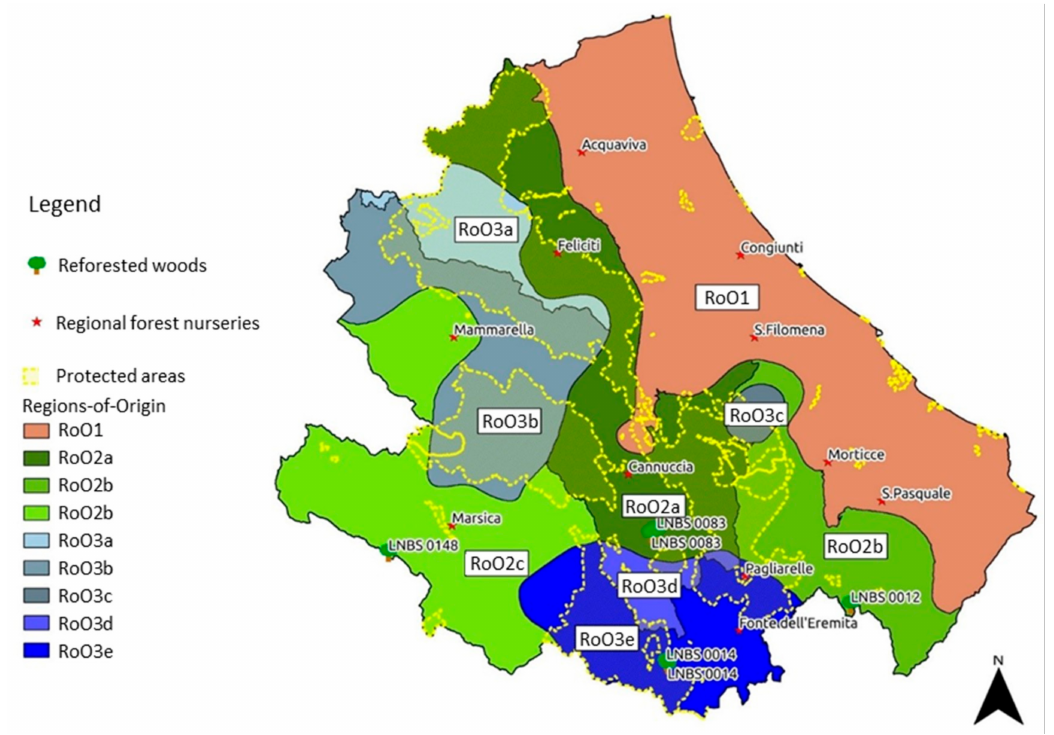
Figure 6. Subdivision by vegetation.